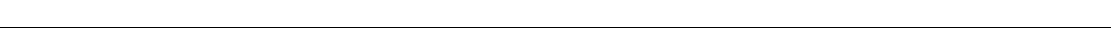
Fig. 6 Gustatory neuron sub-clusters and the somatosensory neuron cluster differ in their neurotransmitter phenotype. a . FPKM values for the most prominent purinergic, serotonergic, and GABAergic receptors expressed in 96 sequenced geniculate ganglion neurons. Neurons are arrayed as in Figs. 4a and 5b, with T1 (green), T2 (orange), and T3 (pink) sub-clusters of gustatory neurons followed by somatosensory (black) neurons. b . Heat map based on single-cell RT-qPCR in 38 manually isolated geniculate ganglion neurons. Based on expression pattern for P2rx2 , P2xr3 , Htr3a , and Gabra1 , these neurons were classi fi ed post-hoc into the sequencing-derived clusters. c . Geniculate ganglion from Htr3a -GFP mouse reveals that some GFP+ neurons are P2rx2- immunoreactive ( fi lled arrowhead) while other GFP+ neurons lack P2rx2 ( Δ ). GFP is visualized by native fl uorescence, without immunostaining. d . Immunostaining for Gabra1 in a geniculate ganglion from a Htr3a -GFP mouse. The majority of neurons are brightly or faintly immunoreactive for Gabra1, consistent with sequencing data. Occasional neurons that are GFP-bright but lack Gabra1 (un fi lled triangle) may represent gustatory sub-cluster T2 or the somatosensory cluster. e . Representative traces from Ca 2+ imaging of GCaMP3-expressing geniculate ganglion neurons, acutely dissociated, cultured and stimulated with ATP (10 μ M) in the presence or absence of extracellular Ca 2+ in the bath. Traces for four neurons that responded (black) to ATP and three that did not (grey) are shown. f . Representative traces showing different patterns of responses from four neurons that were sequentially stimulated with 10 μ M ATP, 10 μ M 5HT and 50 mM KCl. Superimposed black and grey traces are replicate responses of the same cell. e . HCA of Ca 2+ responses in 148 neurons to ATP, 5HT and GABA (3 experiments, 12 ganglia). The dendrogram sorted all 148 neurons into four groups based on patterns of responses. The heat map below the dendrogram shows the magnitude of responses to neurotransmitters ( Δ F/F for ATP and 5HT; % inhibition by GABA). 100% inhibition indicates complete loss of KCl response; − 100% indicates a 2-fold increase in Ca 2+ response to KCl (see Methods and Supplementary Fig. 8d, e). Groupings were re-assigned with RNAseq clusters (colored bars) post-hoc based on the correspondence between response patterns and expression of cognate receptors. All scale bars , 20 µ